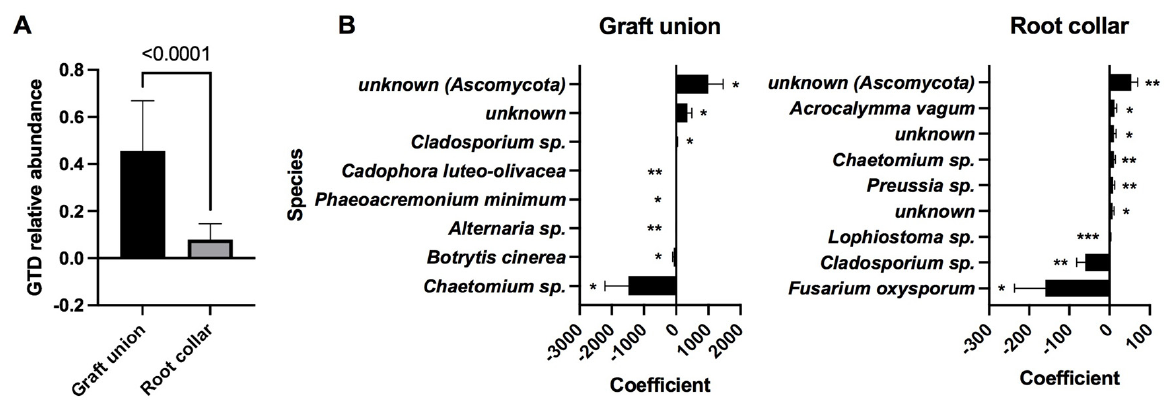
Figure 4. ( A ) Relative abundance (% of total reads) of GTD-related clusters in each tissue type. ( B ) Stepwise analysis of fungal communities correlated with necrosis in graft unions and root collars. Statistically significant coefficients are marked with asterisks: p < 0.05 (*), p < 0.01 (**) and p < 0.001 (***).